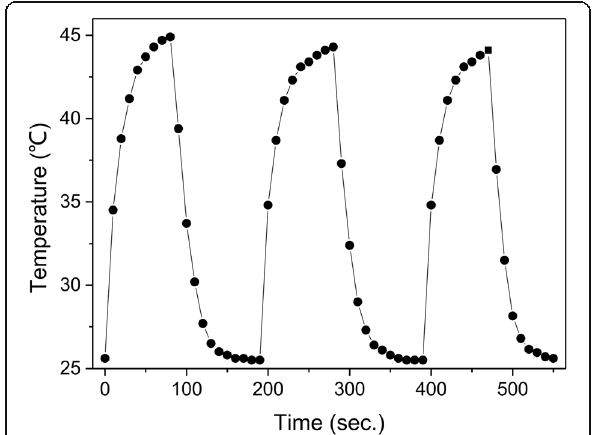
Fig. 8 Cyclic heating profile of the electrospun fiber membranes